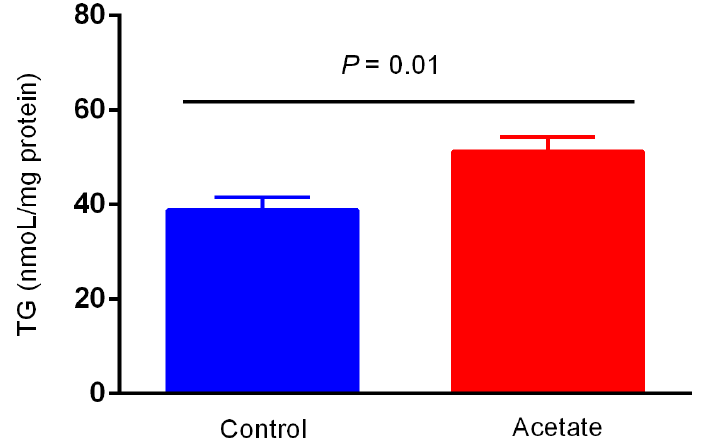
Figure 1. The effect of acetate on intracellular triacylglycerol (TG) production.